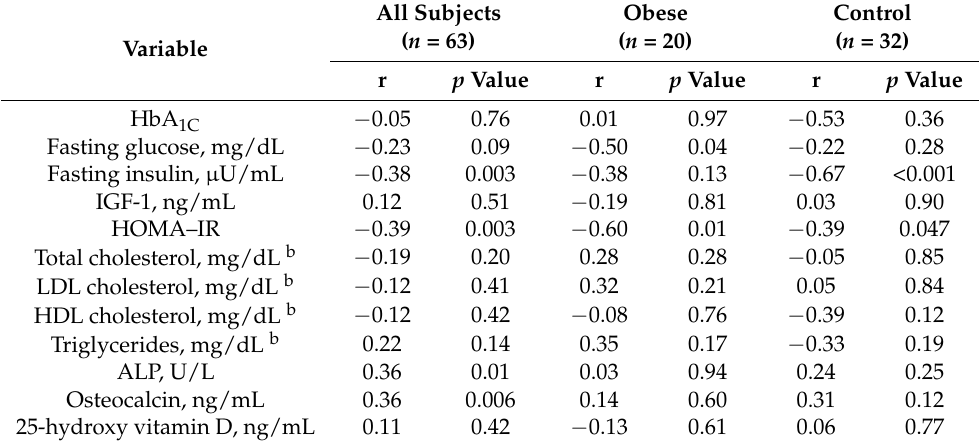
IGF-1, insulin-like growth factor-1; HOMA–IR, homeostasis model assessment–insulin resistance; LDL, low- density lipoprotein; HDL, high-density lipoprotein; ALP, alkaline phosphatase. a Controlled for age, sex, and height SDS. b Measured in 52 participants: 20 obese, 11 overweight, and 21 control